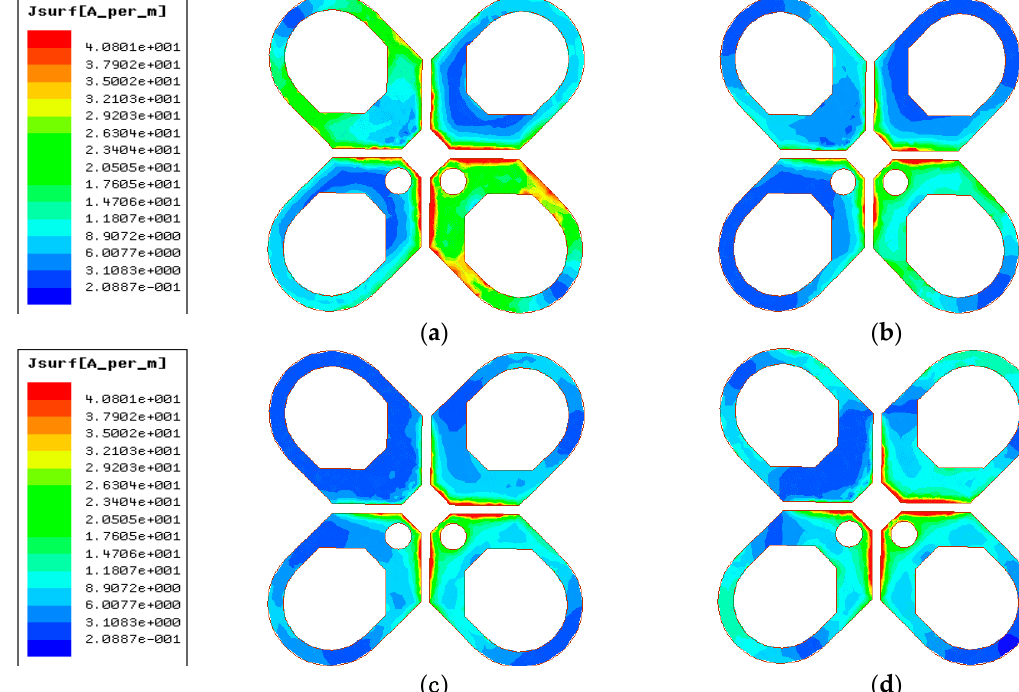
Figure 4. Current distribution. ( a ) 3.4 GHz, ( b ) 4 GHz, ( c ) 4.2 GHz, ( d ) 4.8 GHz. Electronics 2020 , 9 , x FOR PEER REVIEW